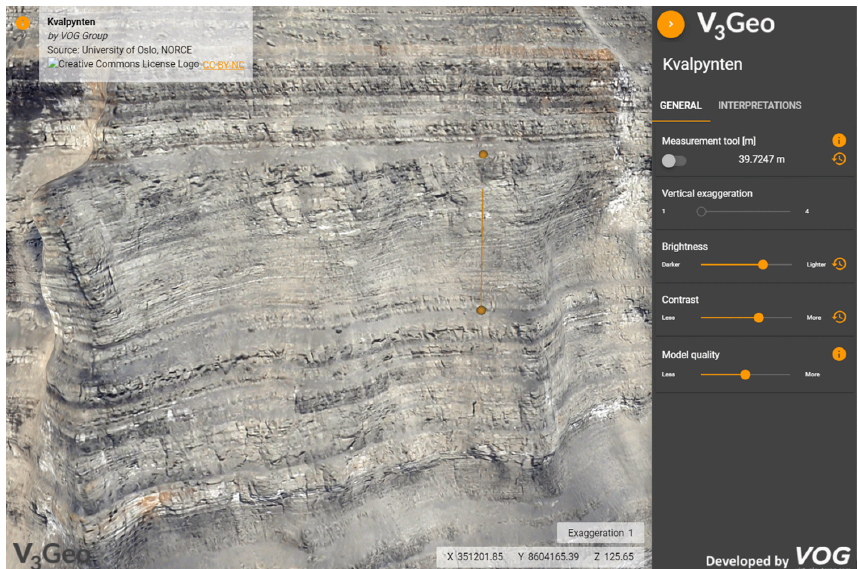
Figure 3. V3Geo web viewer for interactively navigating around tiled 3D models stored in the repository. The example shows point bars exposed at Kvalpynten (Anell et al., 2021; Kvalpynten, VOG Group, https://v3geo.com/model/90, last access: 6 February 2022, CC BY-NC). The complete model covers ca. 26km of outcrop combined from eight processed sections. The measurement tool has been used to mark a distance of